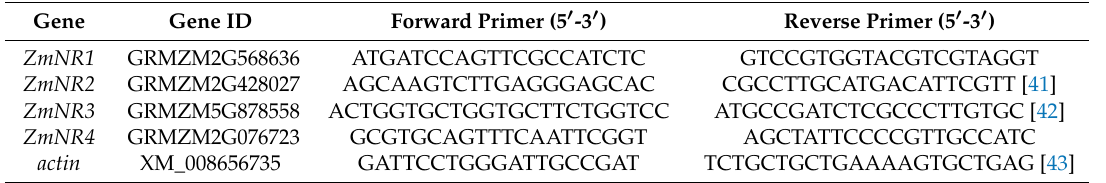
Table 1. Primers for the